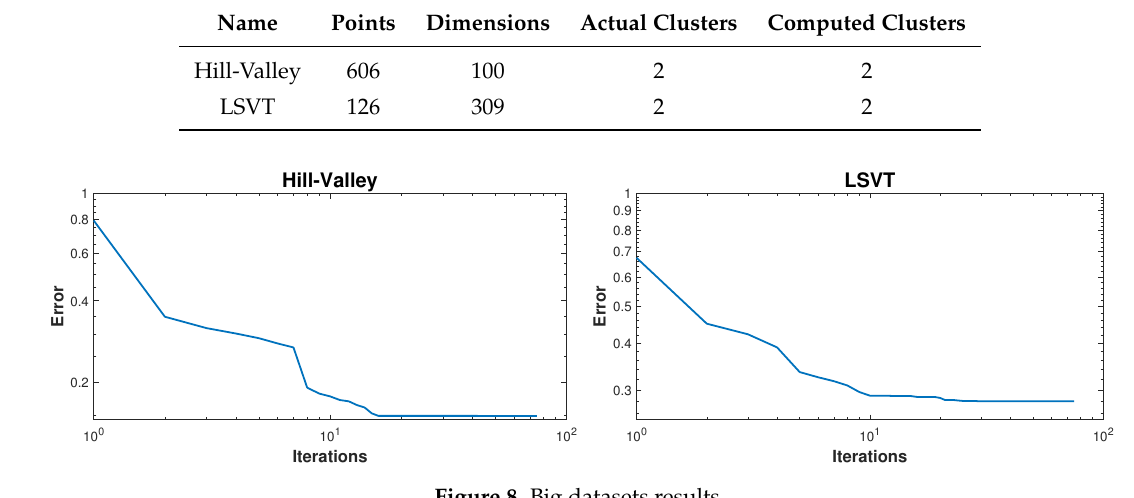
Figure 8. Big datasets results.